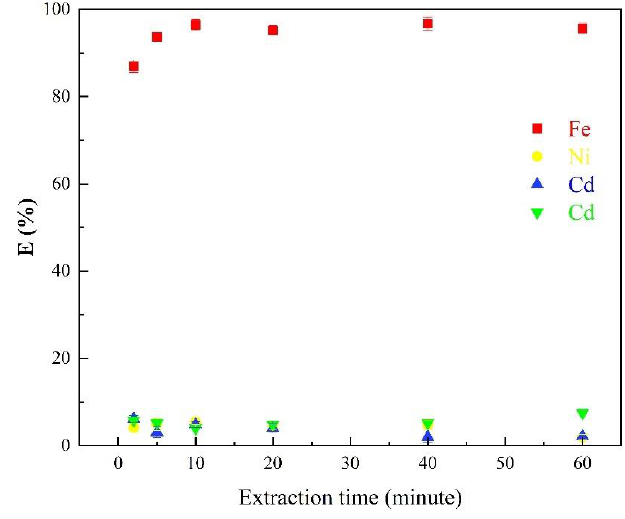
Figure 4. Effects of extraction time under the conditions: room temperature (298 K), [D2EHPA] = 1 mol/L, initial [Fe 3+ ] = 12.25 g/L, saponification rate = 70%, initial pH = 1.00, and phase ratio = 1:1.